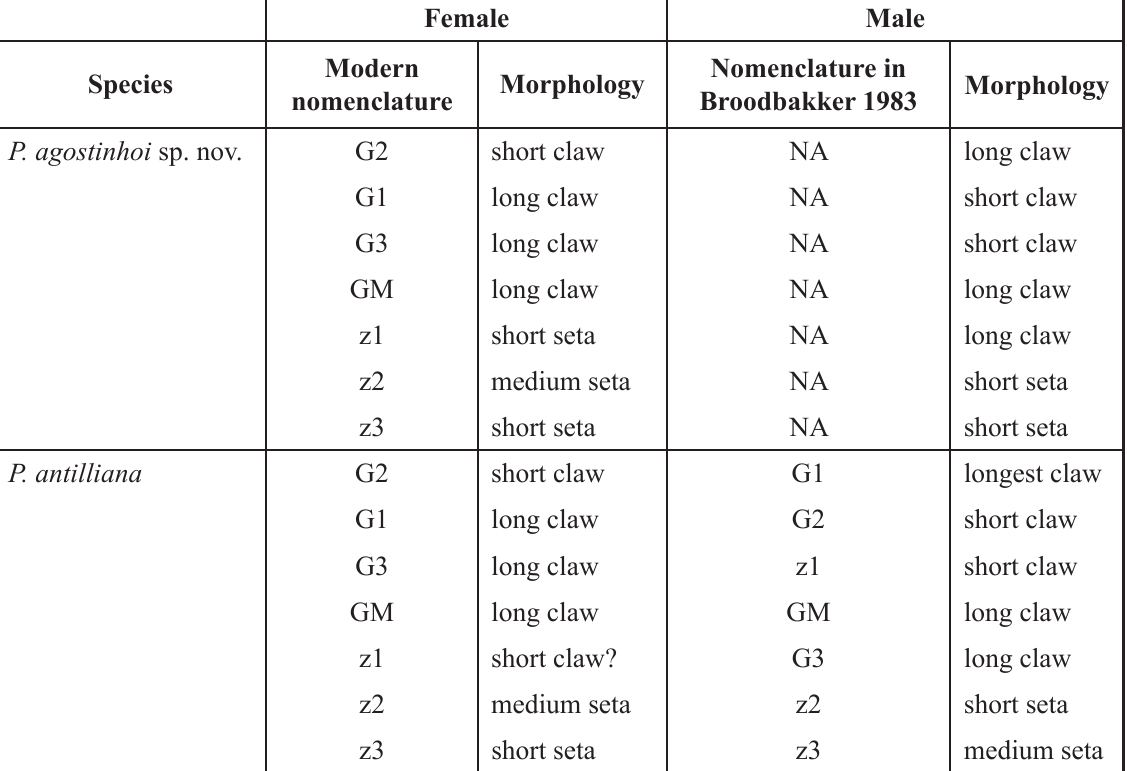
Table 4. Re-appraisal of the homology of claws and setae on two species in the P. caribbeana group, based on Broodbakker (1983) and Martens (1987), NA =